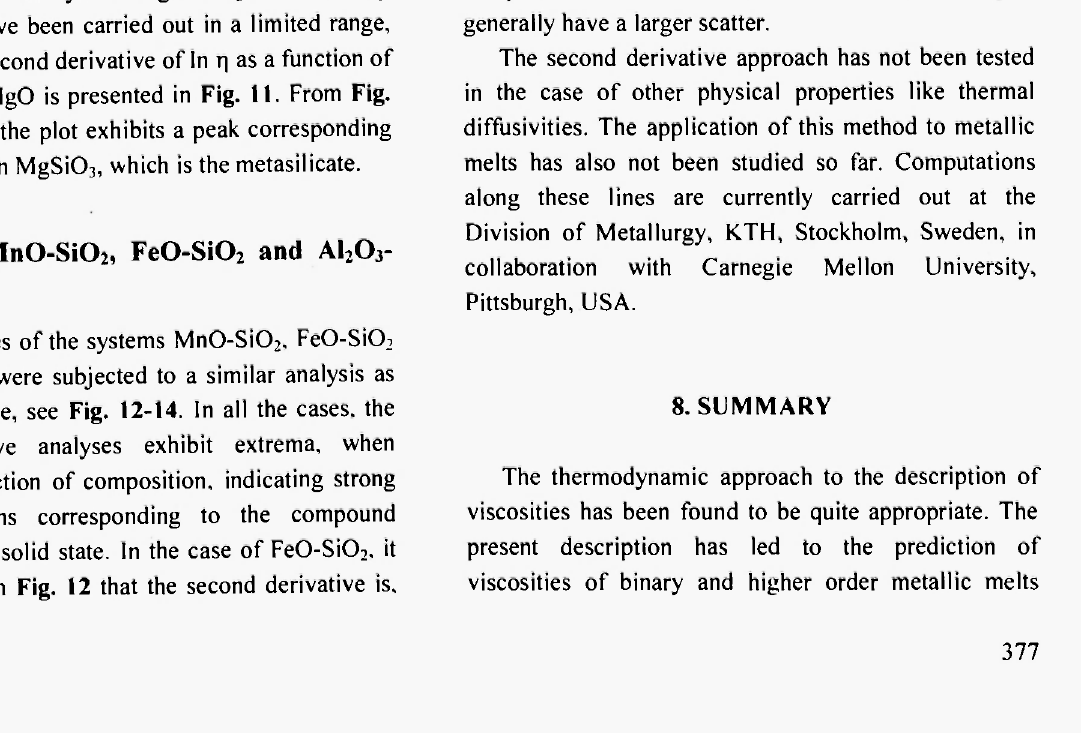
The first and second derivatives of the activation energies for viscous flow for pure water